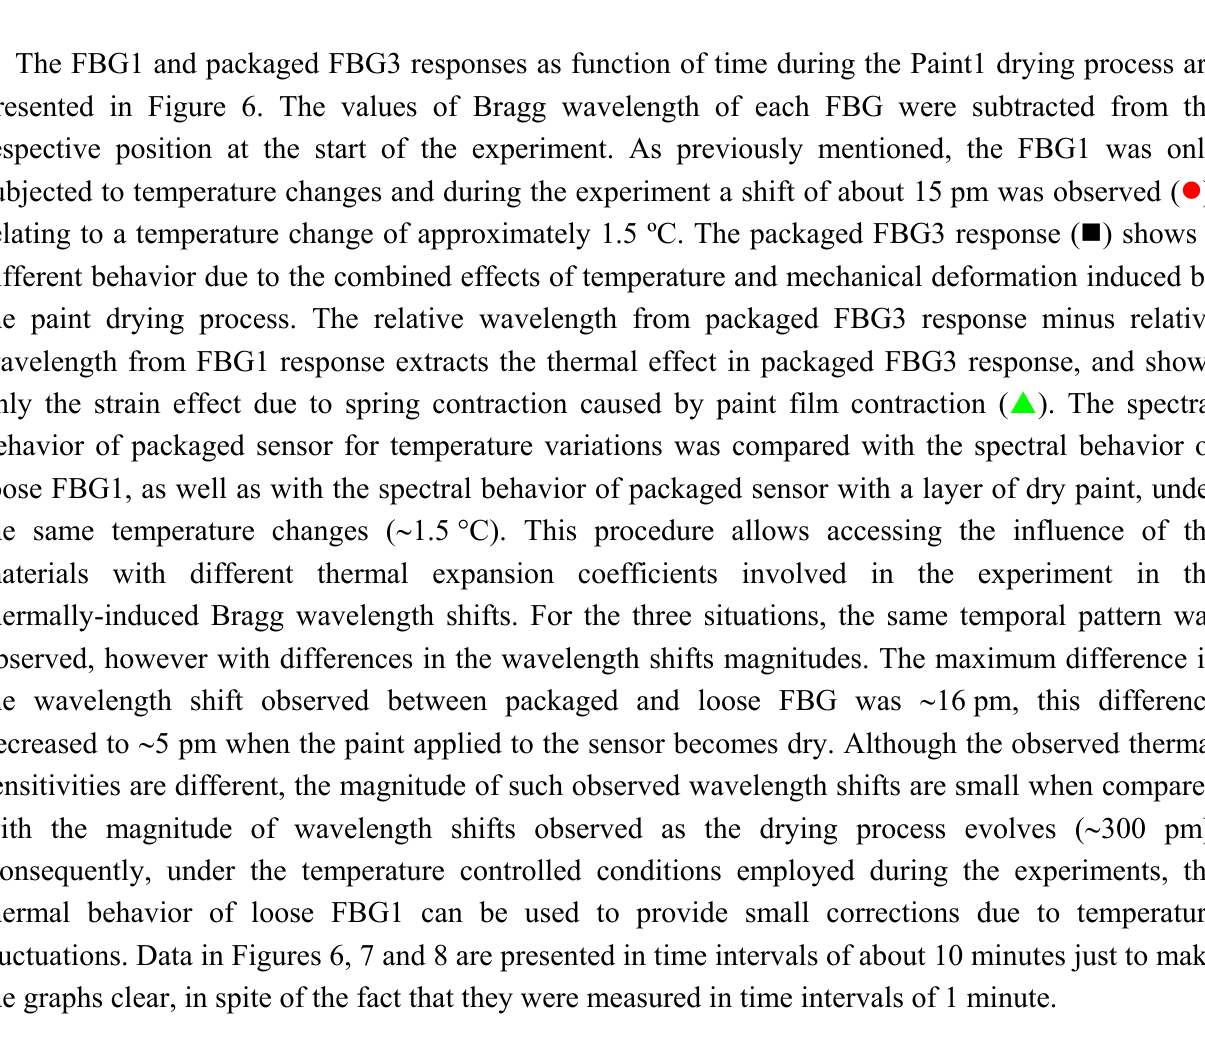
Figure 6. FBG1, packaged FBG3 and thermal compensated FBG3 responses as a function of time during the Paint1 drying